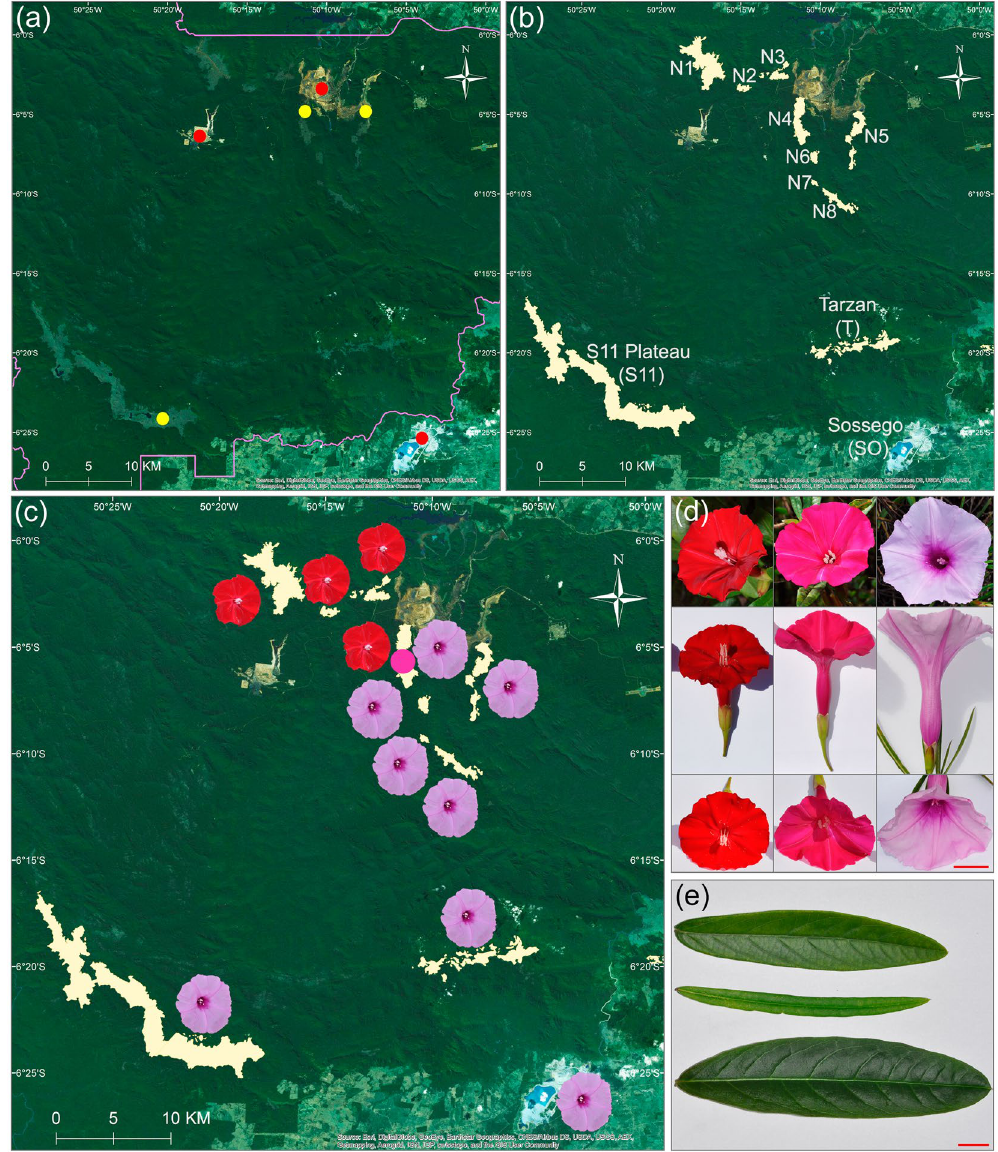
Figure 1. ( a ) Map of the Carajás National Forest. Forest boundary is indicated with the purple line. The patchy light green areas are deforestation areas used for agriculture and cattle pastures. Intense green color is a mountain rain forest. Paler green areas within the Forest are savannahs and granitic inselbergs. Established open-pit mines and the ongoing mine explorations are indicated by the red and yellow dots, respectively. ( b ) Location of the populations used in this study. (c) Distribution of I . cavalcantei (red flowers) and I . marabaensis (lilac flowers). The purple dot indicates the location where putative interspecies hybrids were found in 2016. (d) From left to right, flower of a representative I . cavalcantei individual, flower of a putative hybrid, and flower of I . marabaensis . Bar = 2 cm. (e) Leaves from I . cavalcantei (upper leaf, from Canga N4), I . marabaensis (lower leaf, from S11 Plateau). Individuals of I . marabaensis from populations N5, N6, N8 and Tarzan have narrow lanceolate leaves (middle leaf). Bar = 1